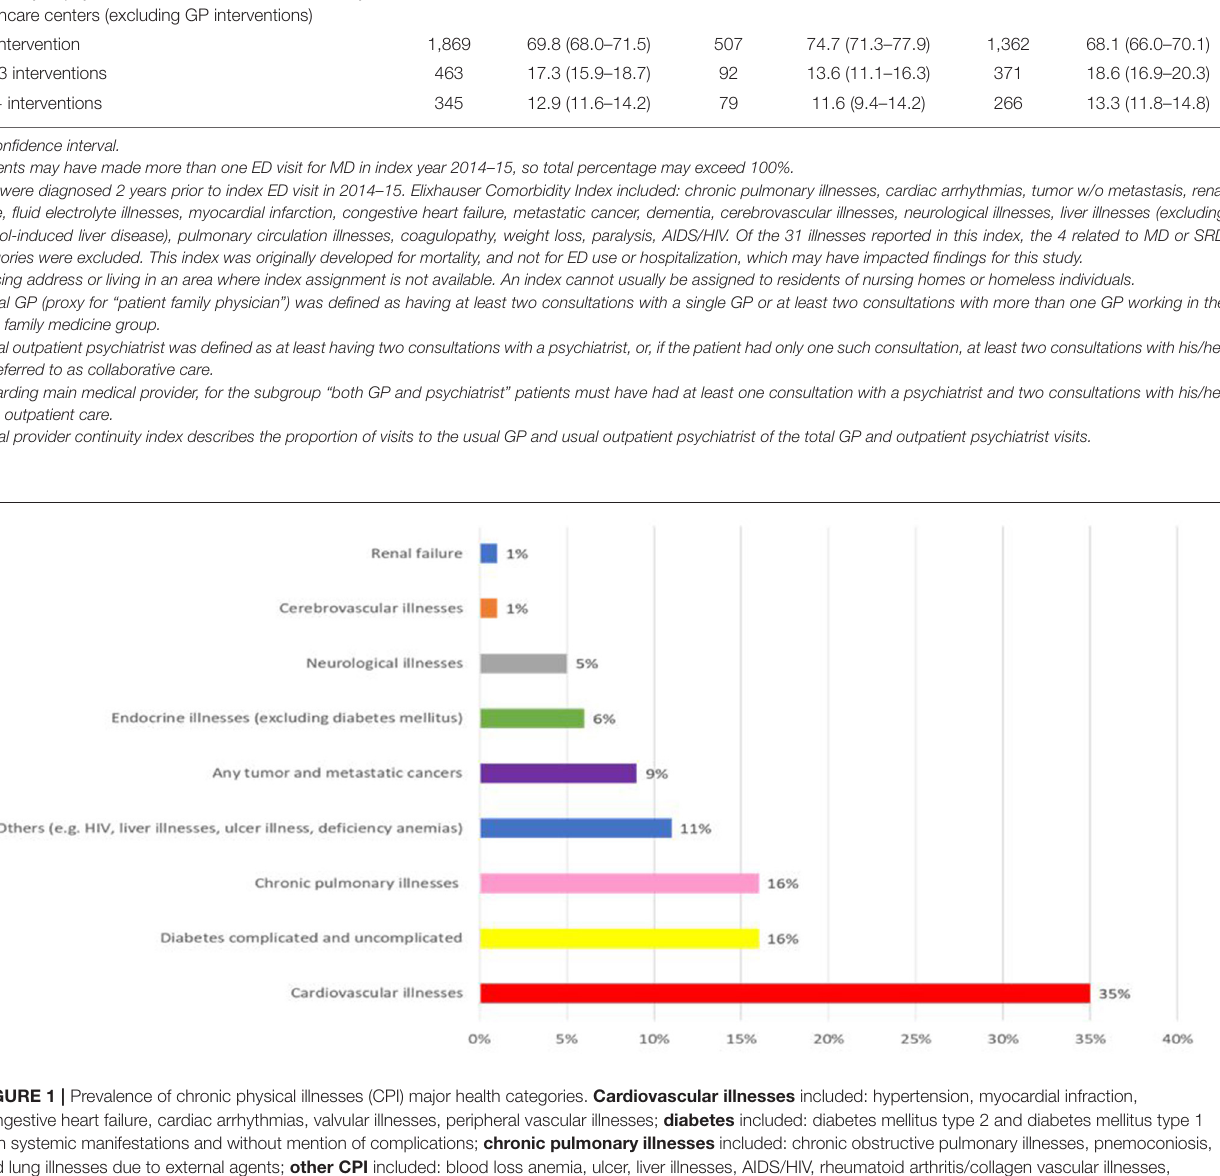
Frontiers in Psychiatry |